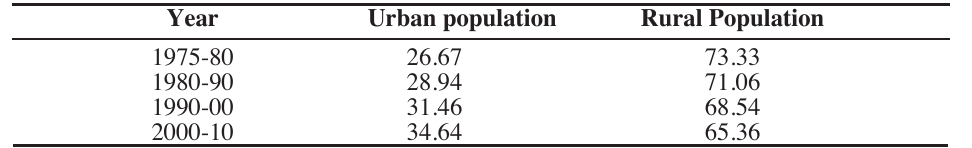
Rural and Urban Population of Pakistan (1975-2010) (As % of total population)